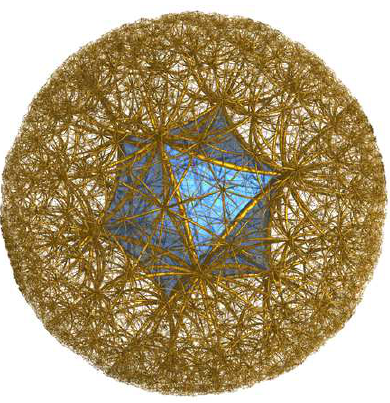
Figure 3. PoincarØ (cid:17)ball(cid:16) model view of the hyperbolic regular icosahedral honeycomb {3,5,3}